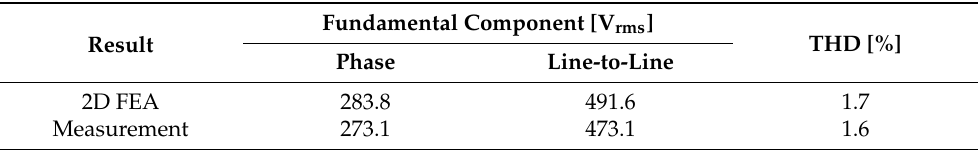
Figure 21. Comparison of 2D FEA and measurement results: ( a ) wave form, and ( b ) harmonic order.